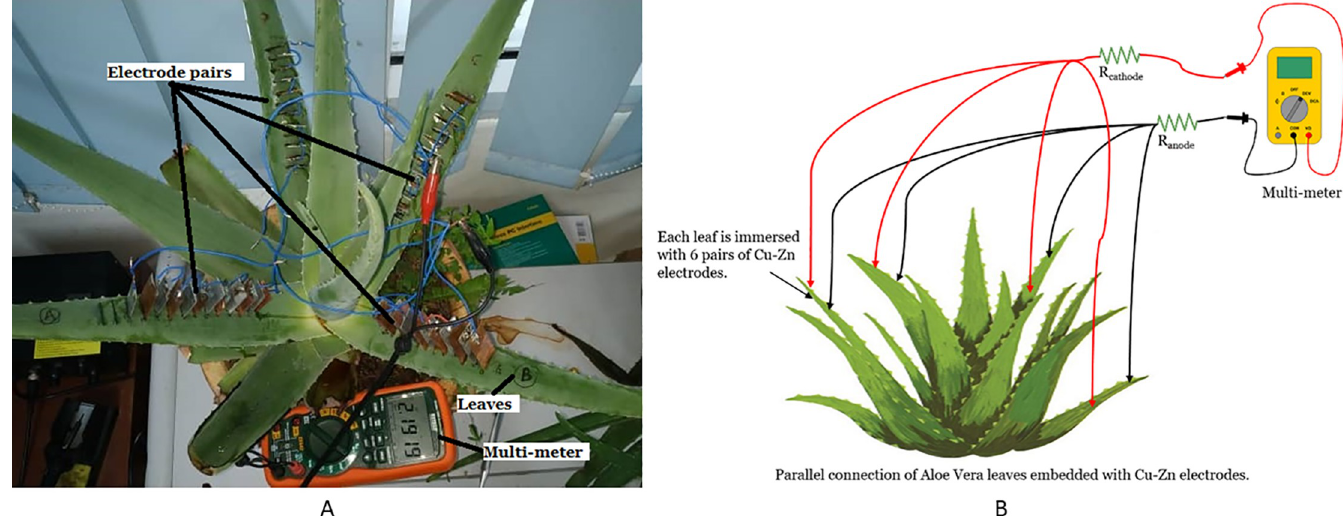
Fig 6. Experiment setup for parallel connection between leaves. Example of setup arrangement (A) and simple schematic of the setup (B).